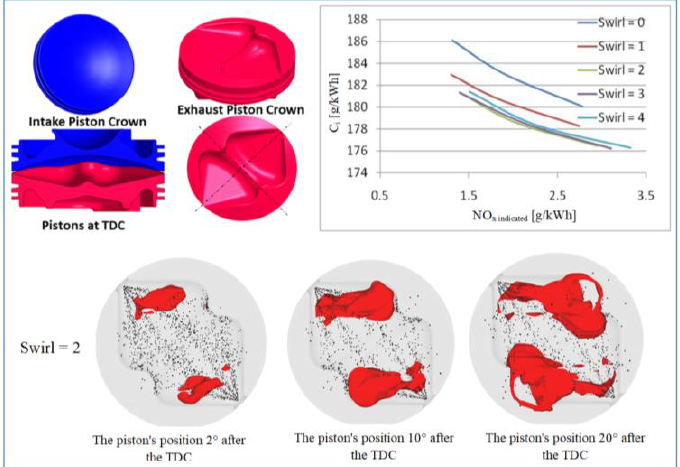
Figure 18. The combustion chamber 2 (butterfly shape) and its performances in virtual